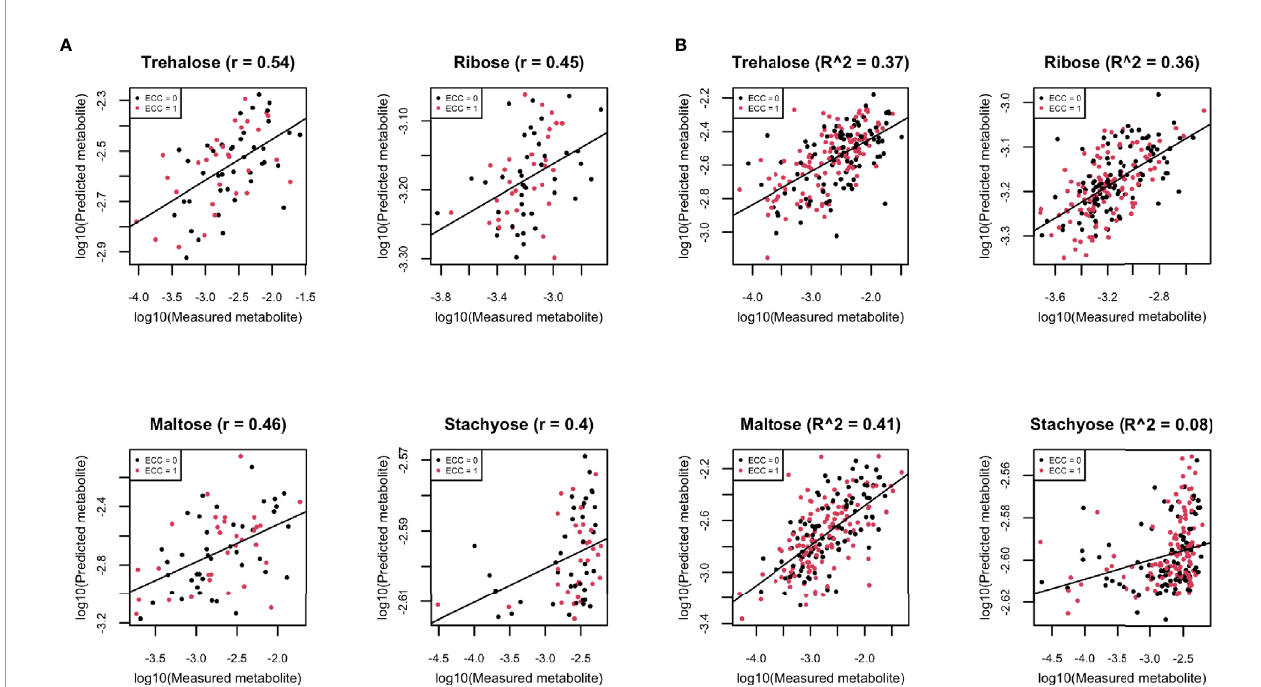
FIGURE 8 | (A) Scatter plots of examples of four well-predicted metabolites in ZOE 2.0 by ENVIM, in the testing set. r is for Spearman correlation for method evaluation. (B) Scatter plots of the same four well-predicted metabolites in ZOE 2.0 by ENVIM, in the training set, where R -square (Pearson Correlation) was shown for the percentage of variance explained by prediction models to demonstrate that over fi tting is not a big concern. The x -axis is the observed metabolites; the y -axis is the predicted metabolites. Both x and y are in log 10 scale of the compositional data for normality. ECC stands for early childhood caries, ECC = 0 (about 50% of total samples in ZOE 2.0) is for the healthy group, and ECC = 1 (about 50% of total samples in ZOE 2.0) is for the ECC case group.